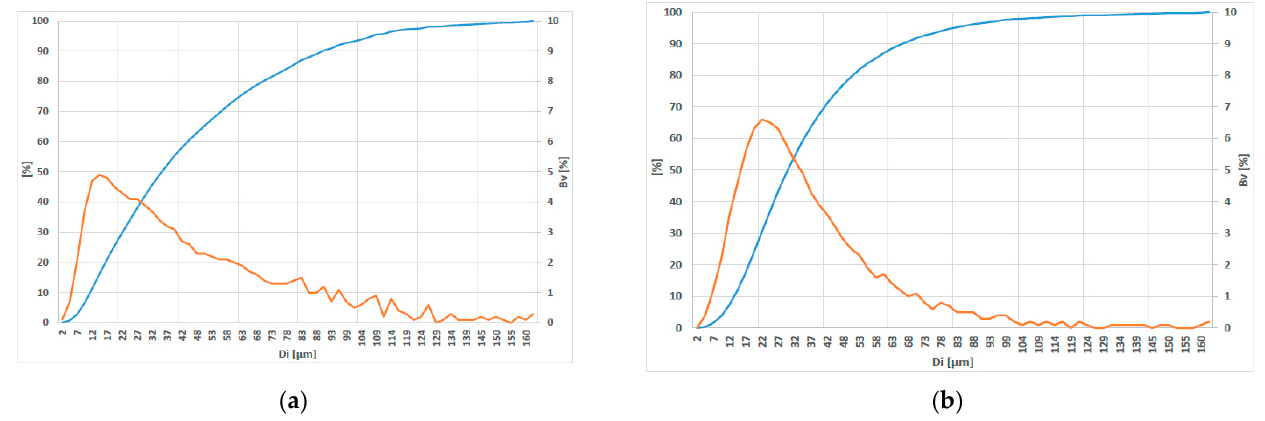
Figure 1. Particle size distribution (differential and integral—refer to volume fraction) of FBC fly ash from brown coal combustion (FBC FA BC)—( a ) and of FBC fly ash from hard coal combustion (FBC FA HC)—( b ), examined using Malvern MasterSizer 2000, with liquid sample dispergator. Isopropanol was used as dispersing liquid. Table 3. Phase composition of the two types of FBC fly ash obtained from brown and hard coal combustion. Phase